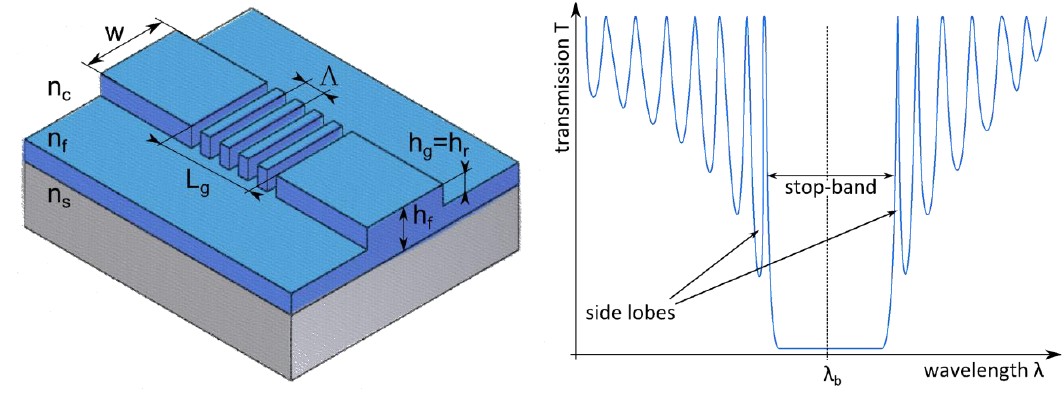
Figure 3. Schematic representation of the considered, planar waveguide based Bragg grating reflector ( left ) with the rib width w and height h r , substrate, film and cover refractive indices n s , n f , n c , grating length L g , period Λ and depth h g , respectively. A typical transmission spectrum of a Bragg reflector at Bragg wavelength λ b is plotted on the right-hand side, highlighting the stop-band and its side